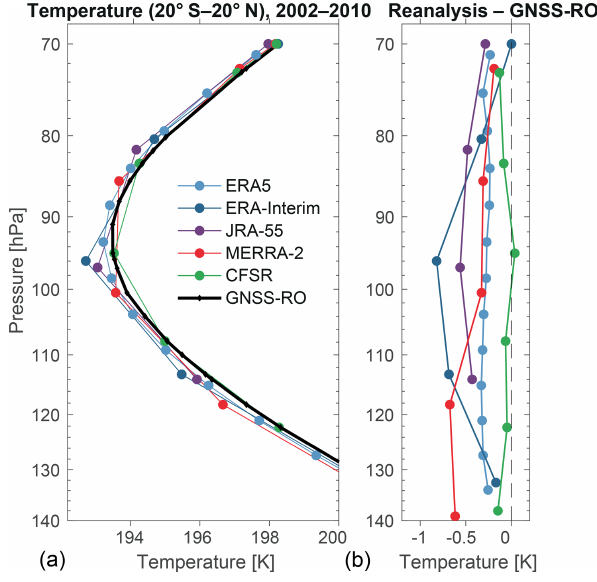
Figure 4. Tropical mean (20 ◦ S–20 ◦ N) temperature profiles at re- analysis model levels between 140 and 70hPa (a) during 2002– 2010 and differences between reanalysis and GNSS-RO tempera- tures (b)